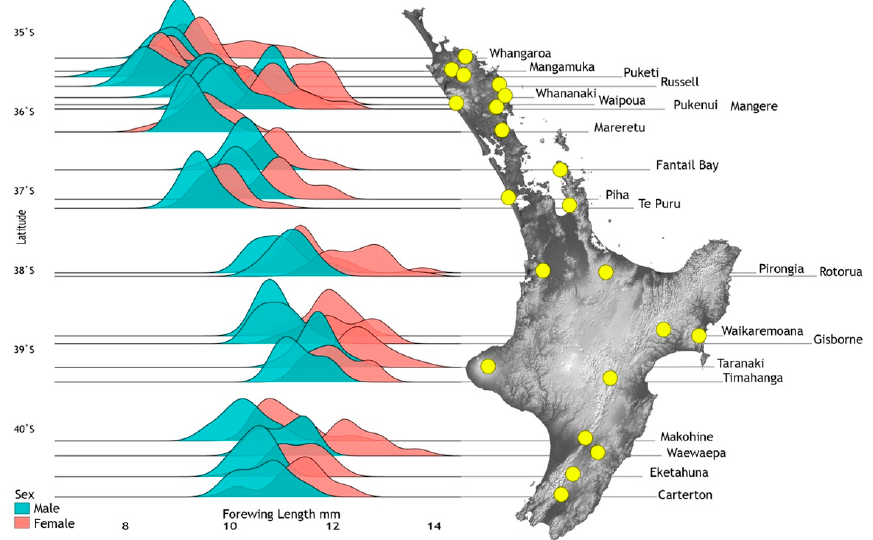
Figure 7. Spatial wing length variation among 21 population samples of adult Acanthophlebia cruentata (N = 888) at locations (yellow spots) across their latitudinal range in North Island, New Zealand. Degrees of latitude are given on the left.